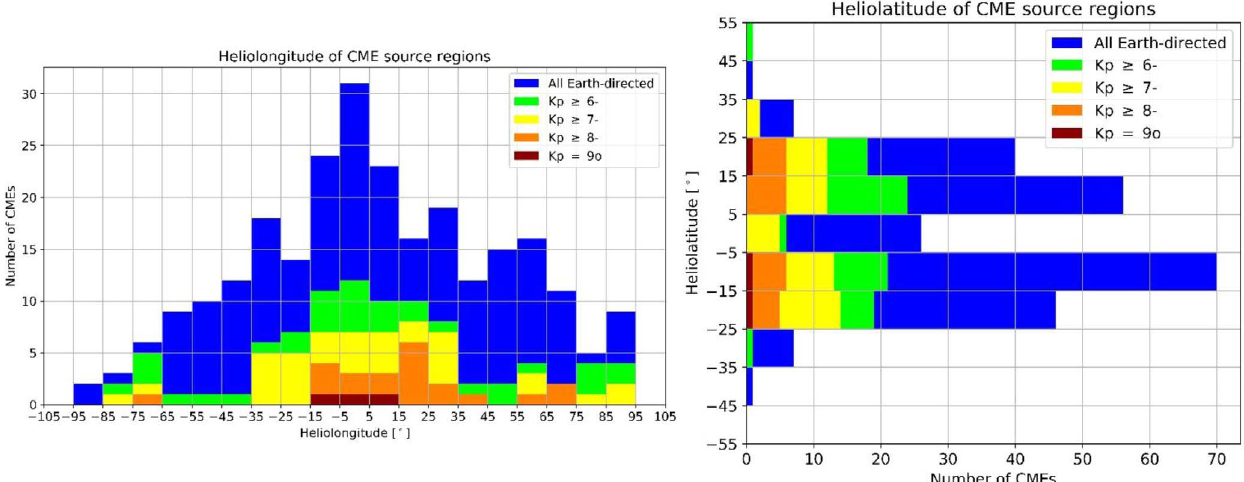
Fig. 2. Count of Earth-directed CME whose source location is known (255 in total), binned by helio-longitude (left) and helio-latitude (right) of any associated fl are or fi lament (blue), together with the count per bin of events that caused storms of Kp (cid:5) 6 (cid:1) (green) through to Kp = 9o